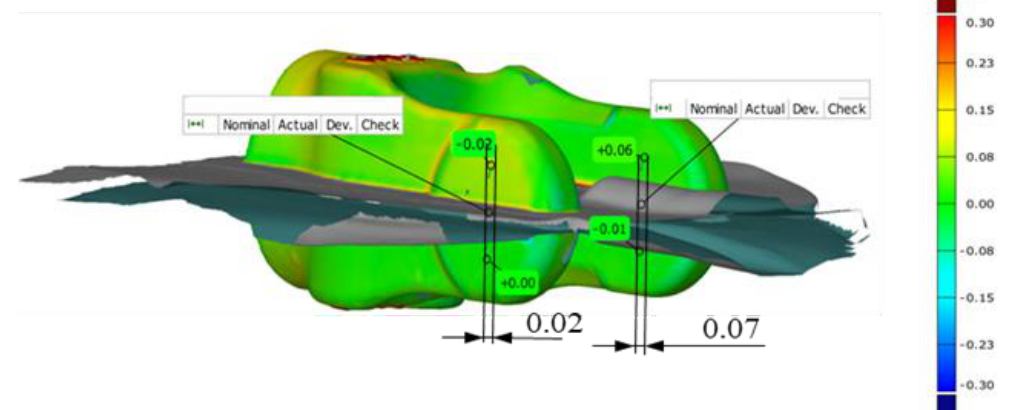
Figure 20. Diagram of the joggle values of two consecutive forgings cyclically collected every 100 items from the process, for a forging bay with corrected geometry: ( a ) components calculated in axis X, ( b ) components calculated in axis Y.